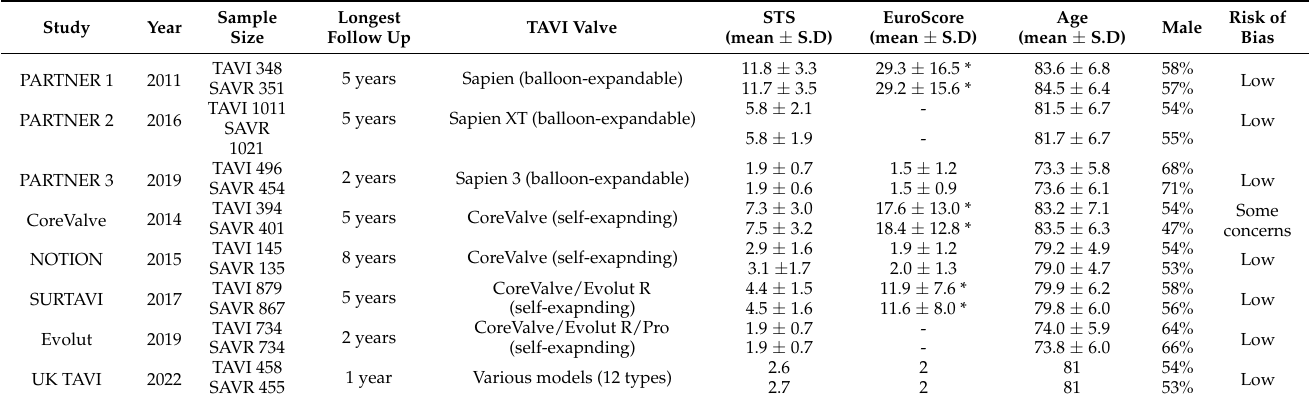
Figure 1. Study selection process for inclusion in the meta-analysis (PRISMA flow diagram). Table 1. Characteristics of studies and patients included in the